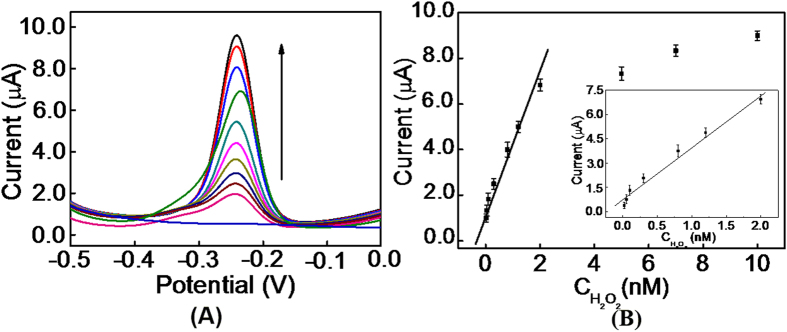
(A) DPV experiments for H2O2 detection in 10 mM of tris-buffer solution (pH 7.4); (B) Calibration curve for the sensor.